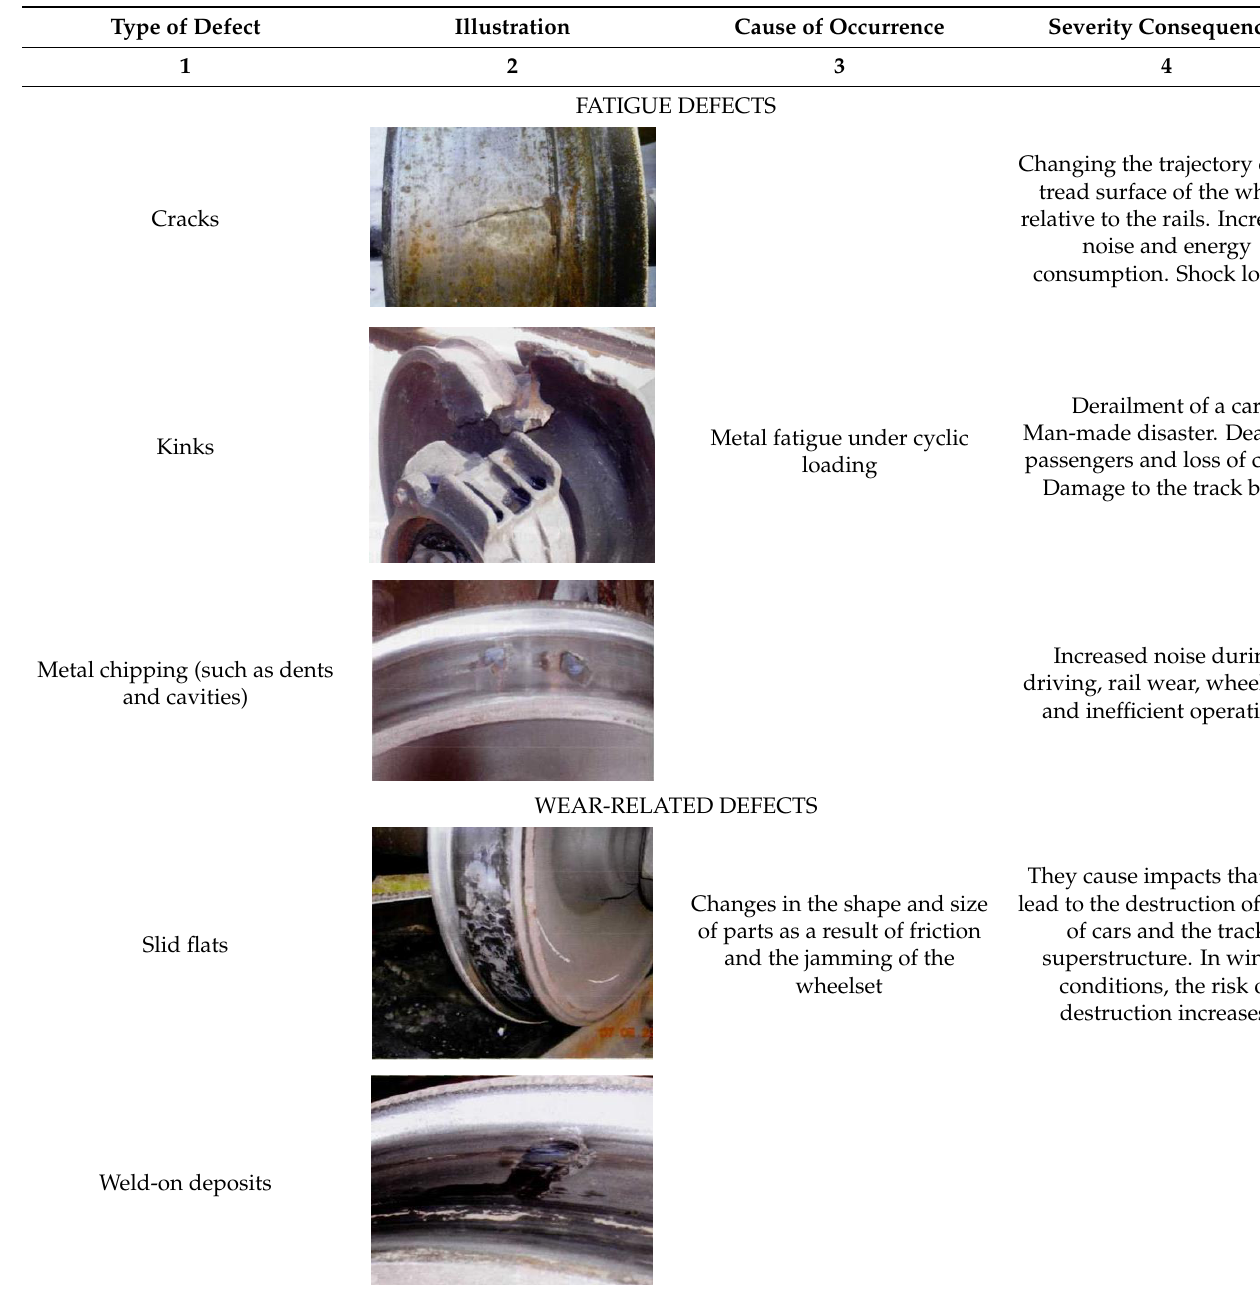
Table 1. Railway car wheelset defects and causes of their occurrence.